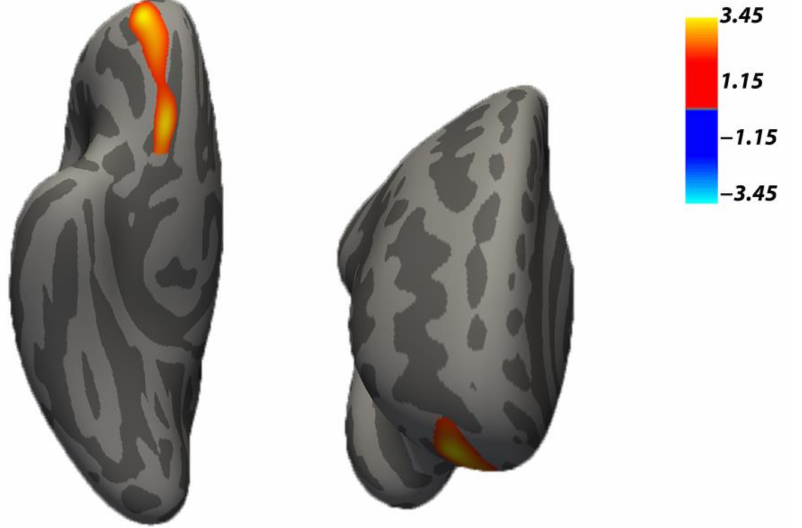
Figure 1. The cortical thickness reduction in Neglect versus Control groups. The cluster comprises the right rostral middle frontal gyrus, as part of the dorsolateral frontal gyrus, and the lateral and medial orbitofrontal areas. Background brain images represent the inferior ( left image) and anterior ( right image) views of the right inflated hemisphere of (FreeSurfer) fsaverage brain. Note: p < 0.05 cluster-wise corrected, 10,000 Monte Carlo iterations, age, and Psychiatric Disorders were included as nuisance covariates for the cortical thickness analysis.